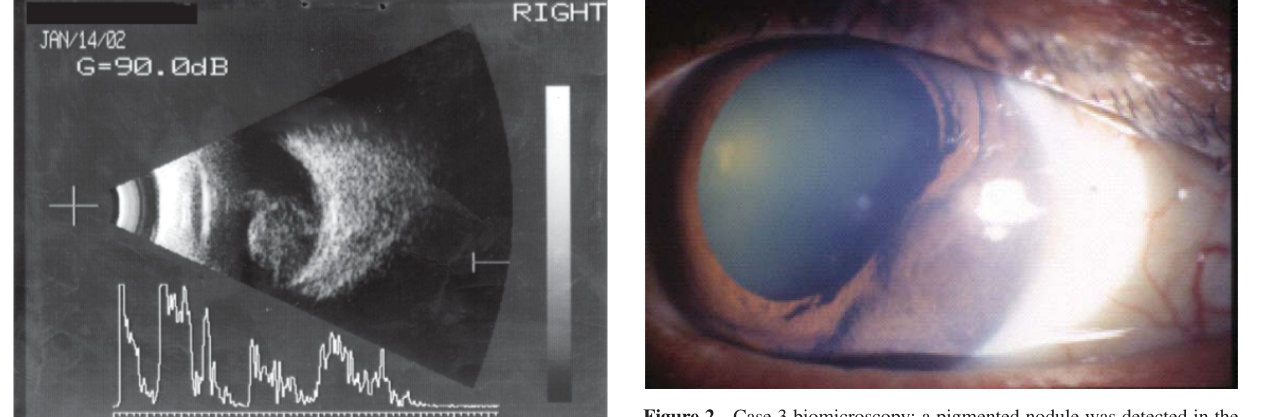
Figure 2 - Case 3 biomicroscopy: a pigmented nodule was detected in the inferior temporal sector of the iris